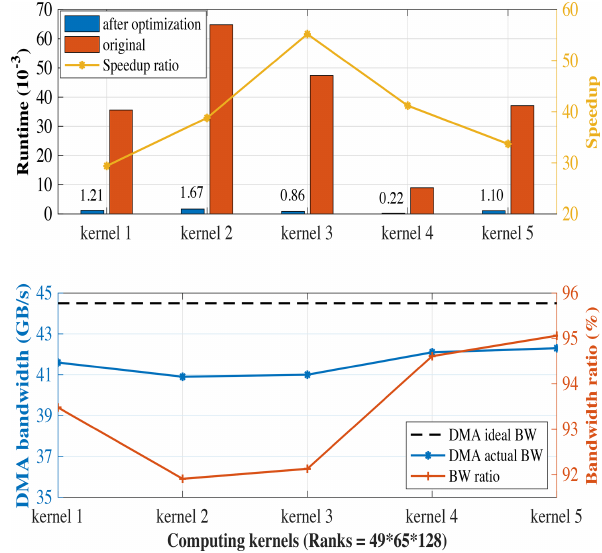
Figure 9. The performance of the five-kernel simulation test and the five kernels are shown in the